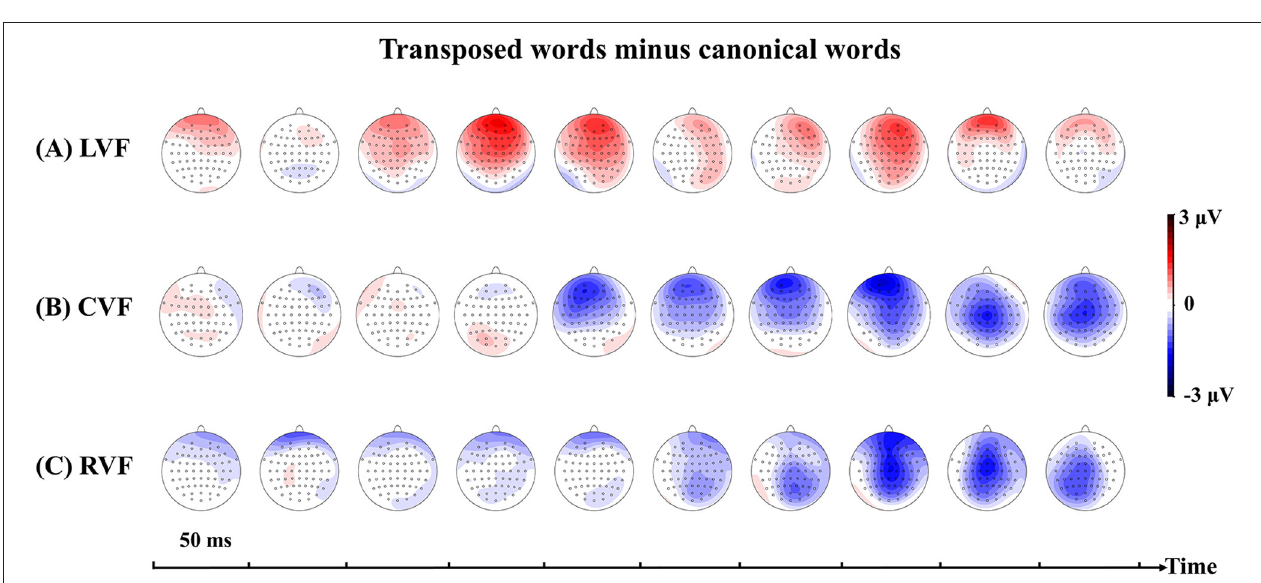
FIGURE 4 | Scalp voltage maps of the ERP transposition effect (transposed word data minus canonical word data) for each analyzed 50–ms time window under three conditions: (A) left visual field (LVF) presentation, (B) centrally presented visual field (CVF), and (C) right visual field (RVF) presentation.